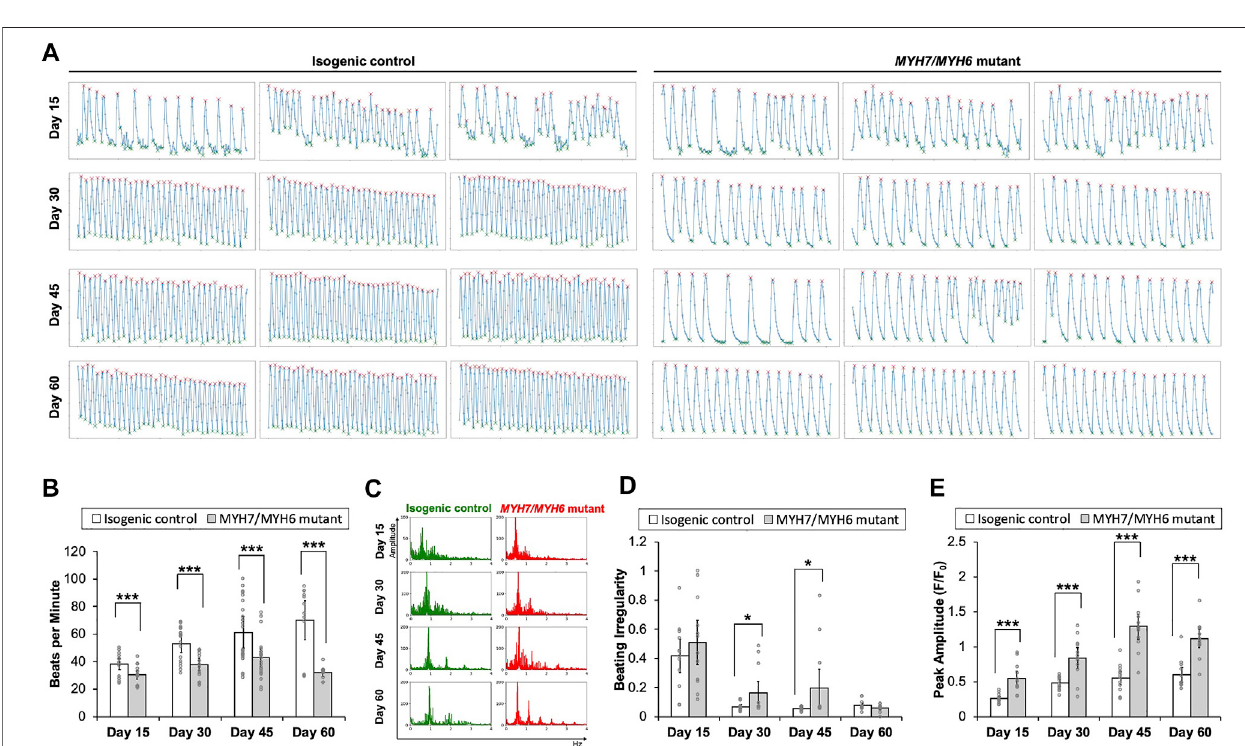
FIGURE3| Functionalassessmentofthe MYH7/MYH6 mutantcardiomyocytes. (A) Calciumtransienttrendsforisogeniccontroland MYH7/MYH6 mutanthiPSC- CMs at Day 15 – 60 of differentiation. (B) Beat rate measured from calcium transient analysis using the isogenic control and MYH7/MYH6 mutant cardiomyocytes at Day 15 – 60 of differentiation. Note the signi fi cant reduction in beats per minute in the mutant cardiomyocytes relative to control. Data represents mean ± SEM; *** p < 0.005; Student t test; three wells of differentiated cardiomyocytes and four videos from separated locations in each well, and n = 12 for each condition. (C) Beat rate in frequency domain for both isogenic control and MYH7/MYH6 mutant cardiomyocytes at Day 15 – 60 of differentiation. (D) Quantitative result for irregular beating in the isogeniccontroland MYH7/MYH6 mutant cardiomyocytes at Day15 – 60ofdifferentiation. Thelevel ofbeating irregularity wasde fi ned astheaveragestandarddeviation forallbeatintervalsovertwelvecalciumtransientmeasurementsforeachcelllineateachtimepoint.Datarepresentsmean±SEM;* p < 0.05;Student t test;threewellsof differentiated cardiomyocytes and four videos from separated locations in each well, and n = 12 for each condition. (E) Peak amplitude of calcium signal measured from calcium transient analysis. Data represents mean ± SEM; *** p < 0.005; Student t test; three wells of differentiated cardiomyocytes and four videos from separated locations in each well, and n = 12 for each condition.